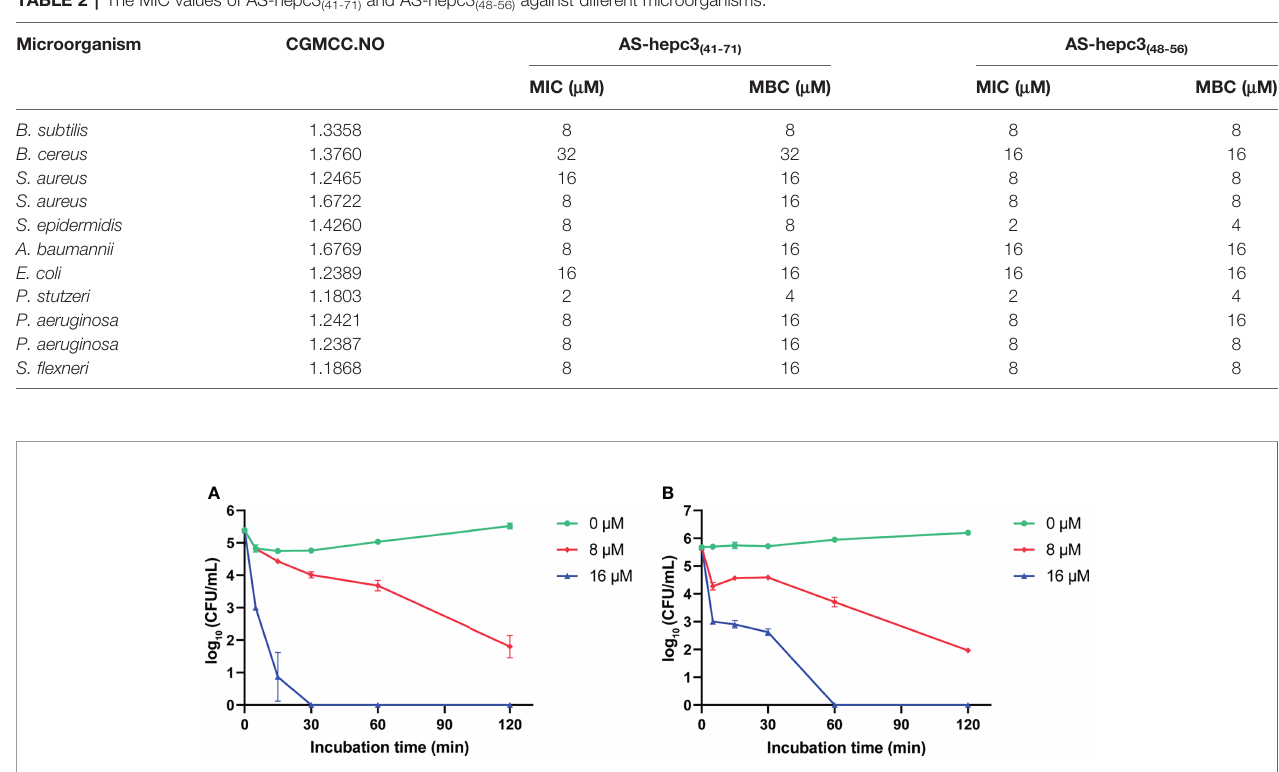
FIGURE 1 | The time-killing curves of AS-hepc3 (41-71) and AS-hepc3 (48-56) on PAO1. (A) The time-killing curve of AS-hepc3 (41-71) on PAO1. (B) The time-killing curve of AS-hepc3 (48-56) on